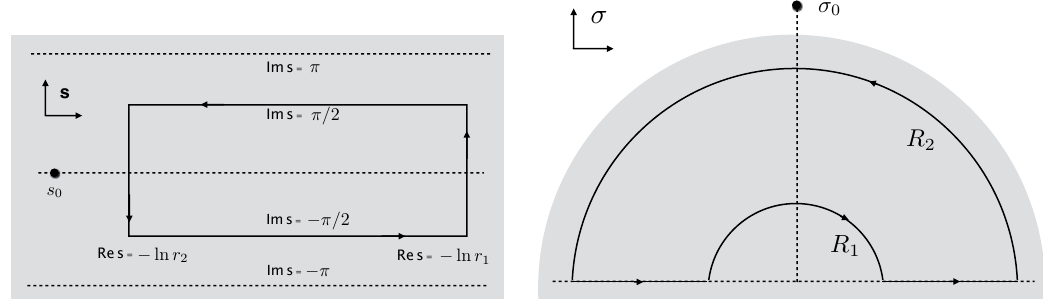
Figure 8 . Left: the contour Γ in the s -stripe; right: the image of Γ in the σ -plane. Γ is chosen to be away from the possible branch-cut singularity s 0 , so that F ( s ) is analytic in the region bounded by